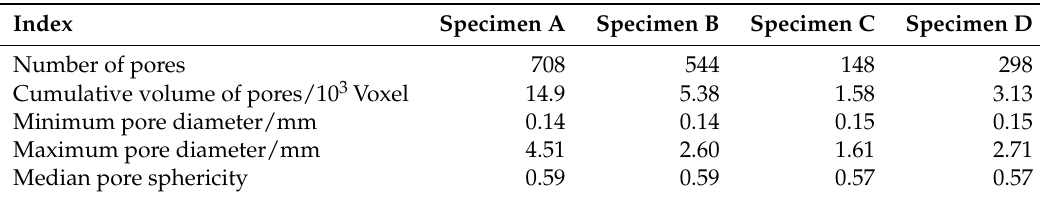
Table 2. Results of the porosity